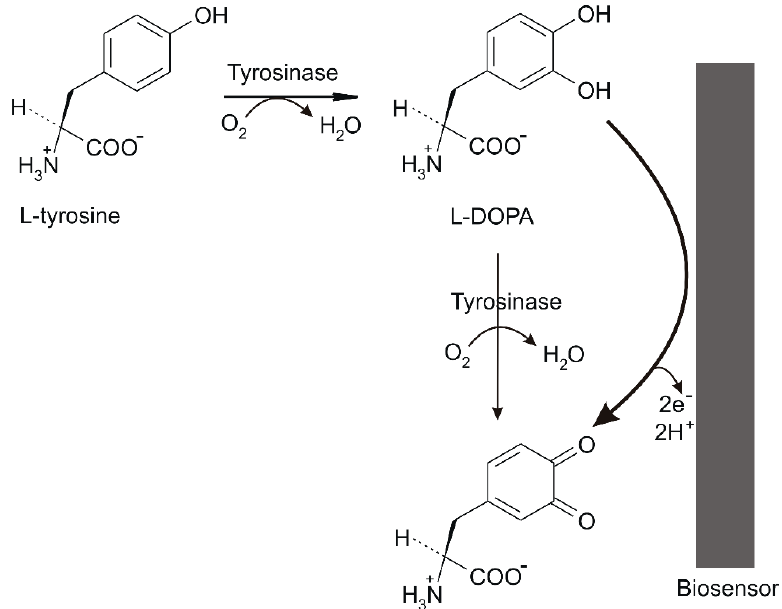
Figure 3. Biosensor detection mechanism.